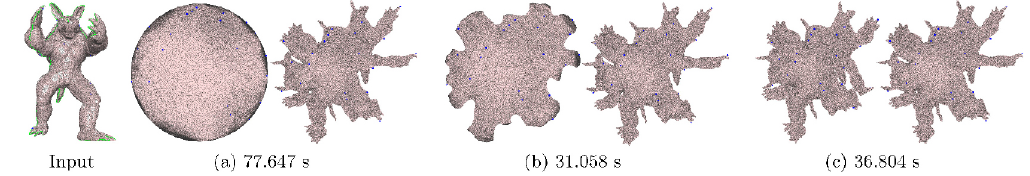
Fig. 9 Three different initial globally injective parameterizations, including Tutte’s embedding [27] (a), the result after running the optimization of Ref. [11] for 5 iterations (b), and the result after running the optimization of Ref. [11] until convergence (c). The total running time of the algorithm is given below each result.